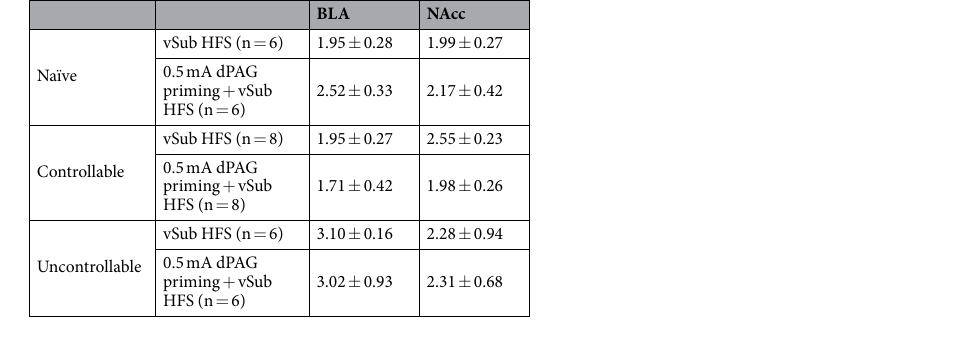
Table 1. Average measurements of input-output curve responses (mA/mV). Averaged peak height amplitudes of the different experimental groups collected during input-output recordings for stimulation intensities calculation in BLA and